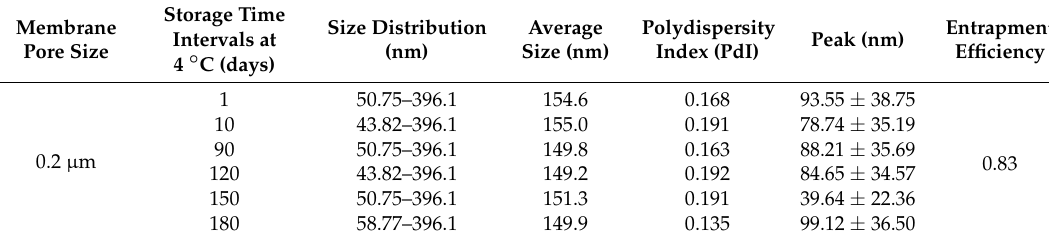
Figure 1. Morphological characterization of liposomal tarin nanocapsules. A scanning electron microscope was used to record DOPE, PEG, and CHEMS nanocapsules (formulation A1). Photographs show liposomes at 20 kV and magnification of 1,200× ( A ); 45,000× ( B ); 14,000× ( C ) and 15,000× ( D ). Table 1. Stability of liposomal tarin nanocapsules.